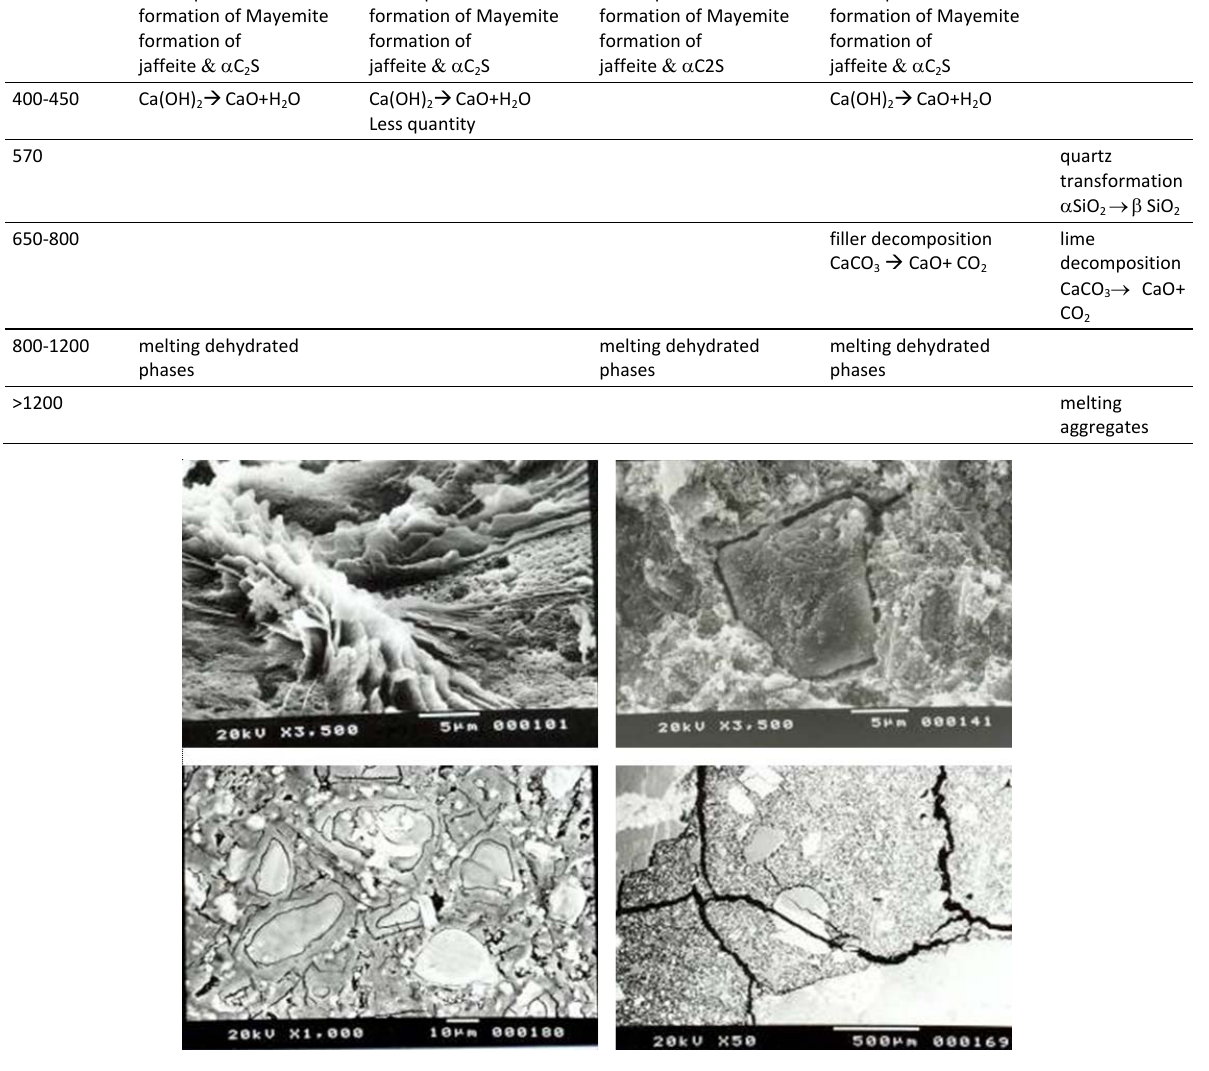
Figure 1. Microstructural changes in HPC after high temperature exposure. a) Dehydrated portlandite 500°C in C60 OPC concrete. b) Alteration of a gabbro aggregate and cement paste in a C70 concrete after 600°C. c) Dehydration of cement paste and anhydrous grains C60 after 500°C and d) Microcracking in dehydrated cement paste and aggregates in C90 (9%SF) concrete after 500°C. Reproduced with authorization from